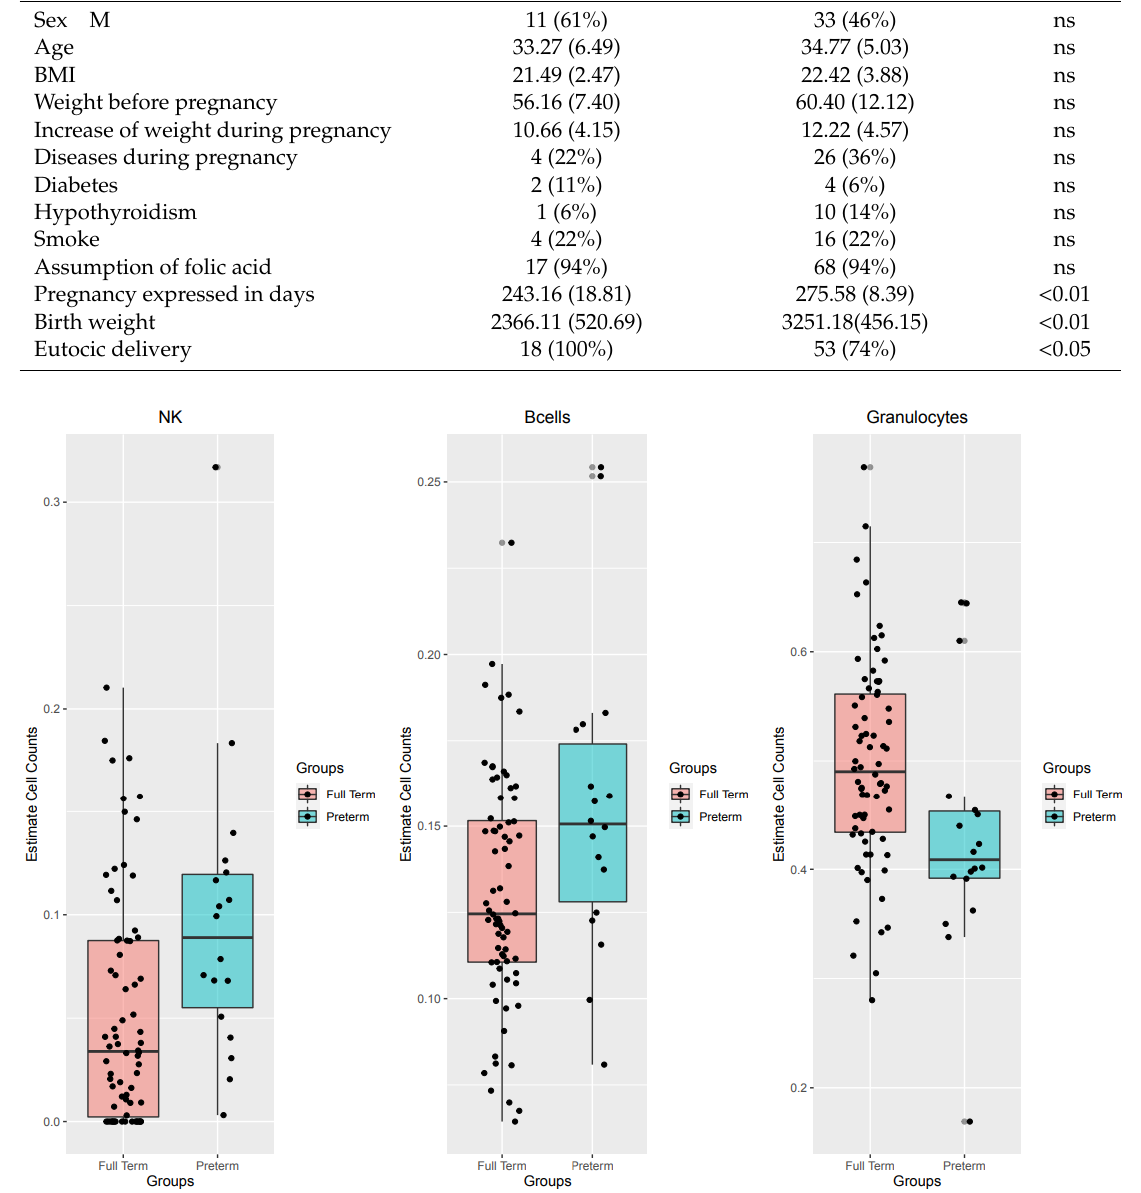
Figure 1. Boxplot showing the distribution of Estimate cell counts between preterm and full-term babies. The thick horizontal line represents the median of the distribution, while the box represents the